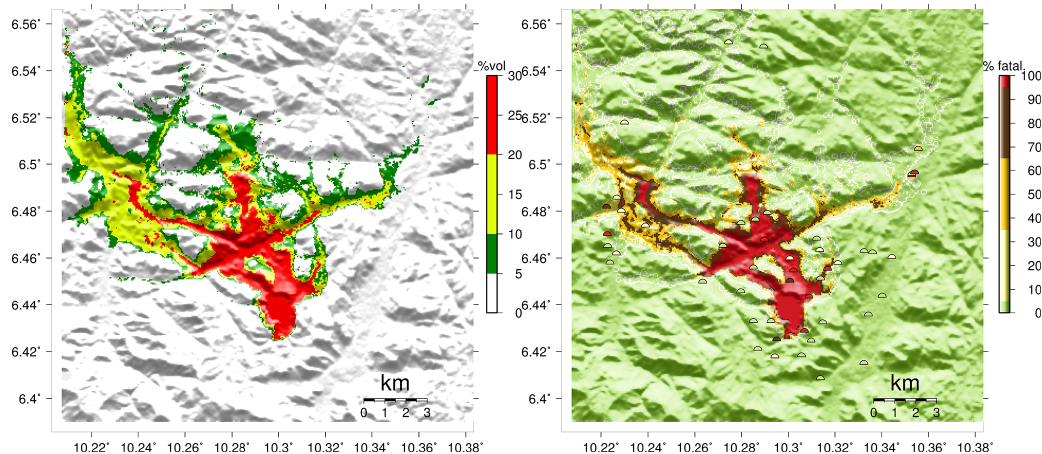
Figure 4. Previous modelling results from Costa and Chiodini (2015) scenario II (4h of gas emission assuming a constant mass flux of 1 . 4 × 10 5 kgm − 2 d − 1 from a diffuse source of 235 × 235m 2 ). Left: maximum CO 2 concentration (%vol.) achieved at 1m height. Right: percentage of fatalities (in %) predicted by the model applying Eq. (7) at 1m height. Halved circles show the actual reported percentages at locations using the same colour